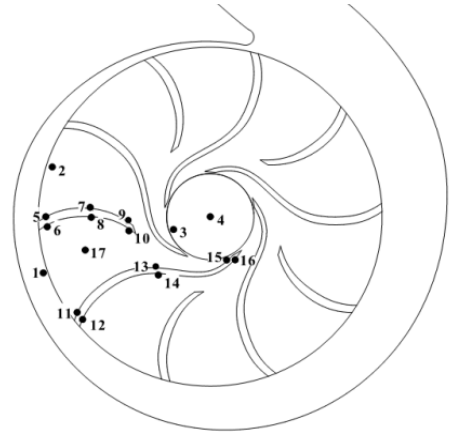
Figure 6. Monitoring sites of PAT.